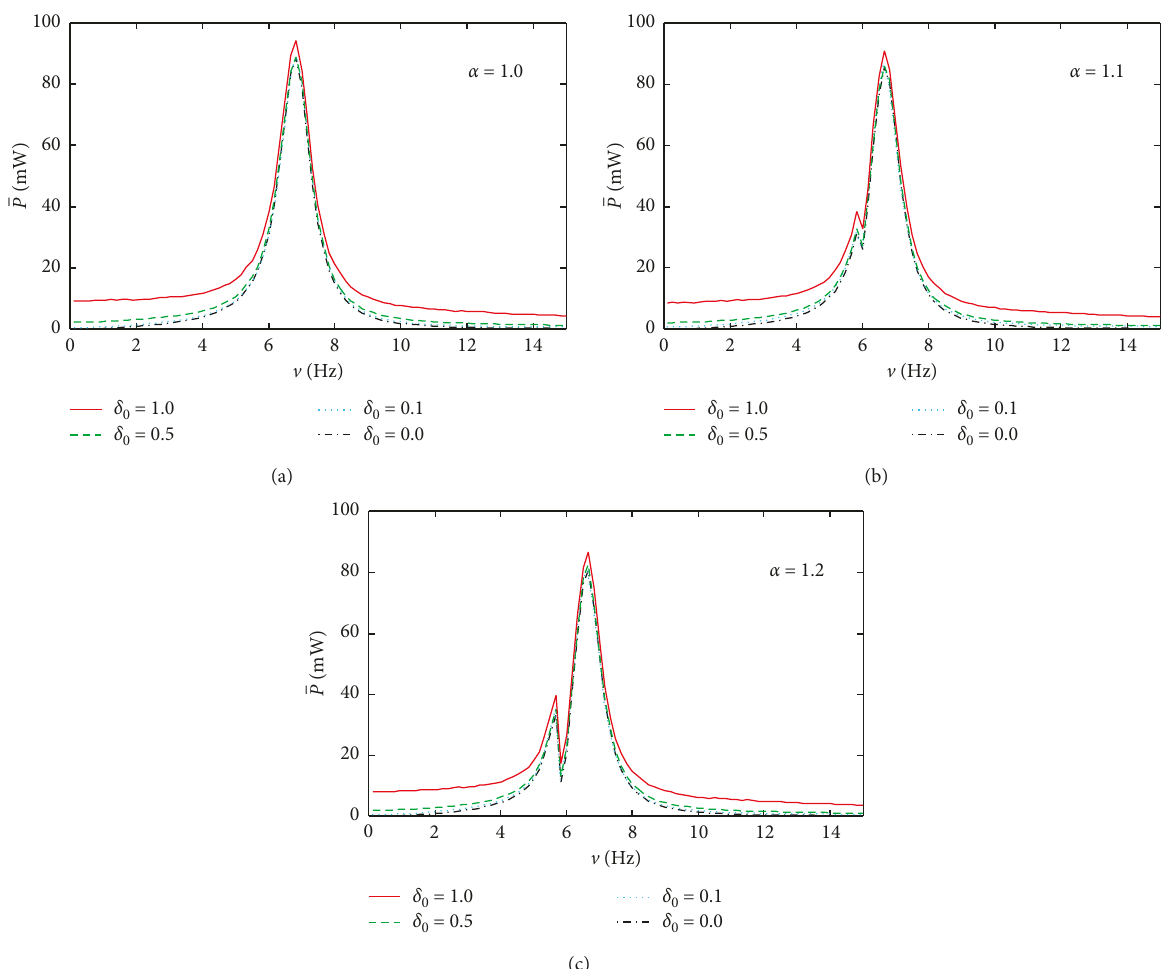
Figure 6: The mean power generated on the electric load R as a function of excitation frequency ] for different values of the mass disproportion parameter α and for different values of δ